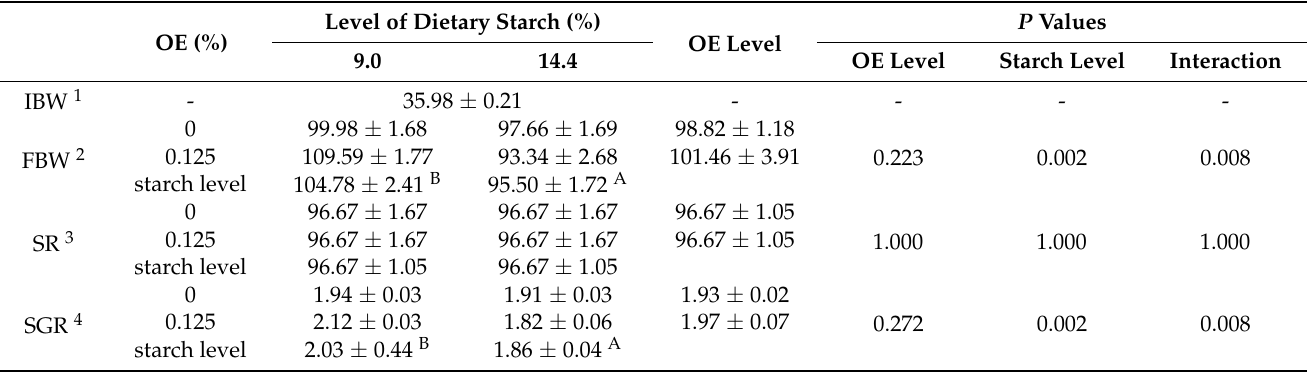
Table 3. Effects of experimental diets on the growth performance in largemouth